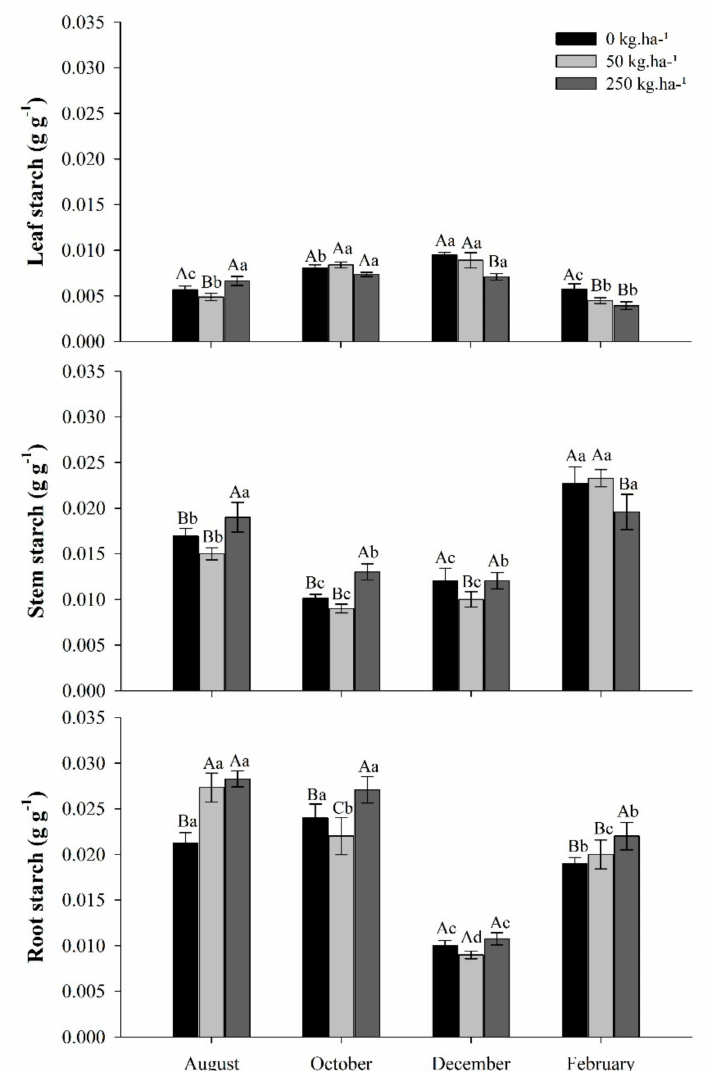
Figure 6. Starch in leaves, stem, and roots of C. guianensis plants fertilized with phosphorus, at different collection periods. Means followed by distinct letters differ from each other ( p < 0.05), where uppercase letters represent the differences between treatments and lowercase letters between the evaluation